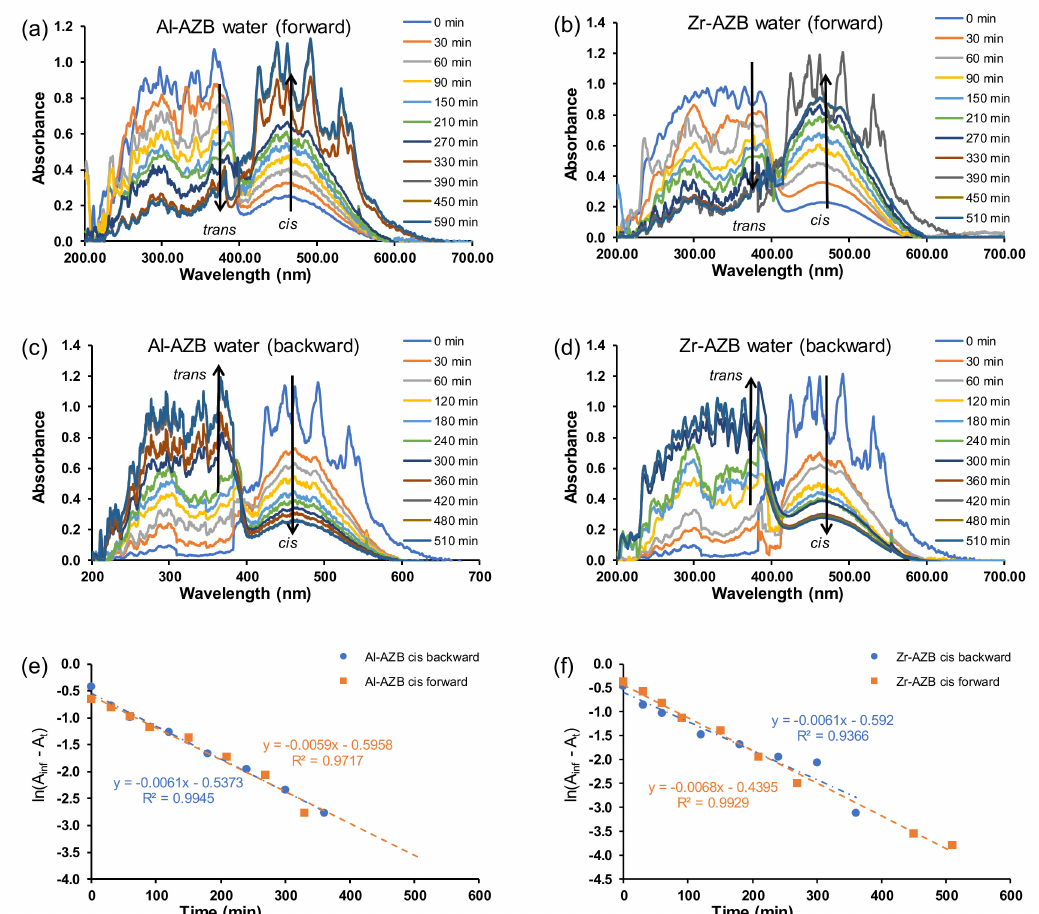
Figure 3. Plot for absorbance vs. wavelength for the forward ( trans–cis ) isomerisation of (50 ppm) ( a ) Al-AZB and ( b ) Zr-AZB. Plot of absorbance vs. wavelength for the backward ( cis–trans ) isomerisation ( c ) Al-AZB and ( d ) Zr-AZB. Plot of ln(A inf - A t ) vs. time for ( e ) Al-AZB and ( f ) Zr-AZB in